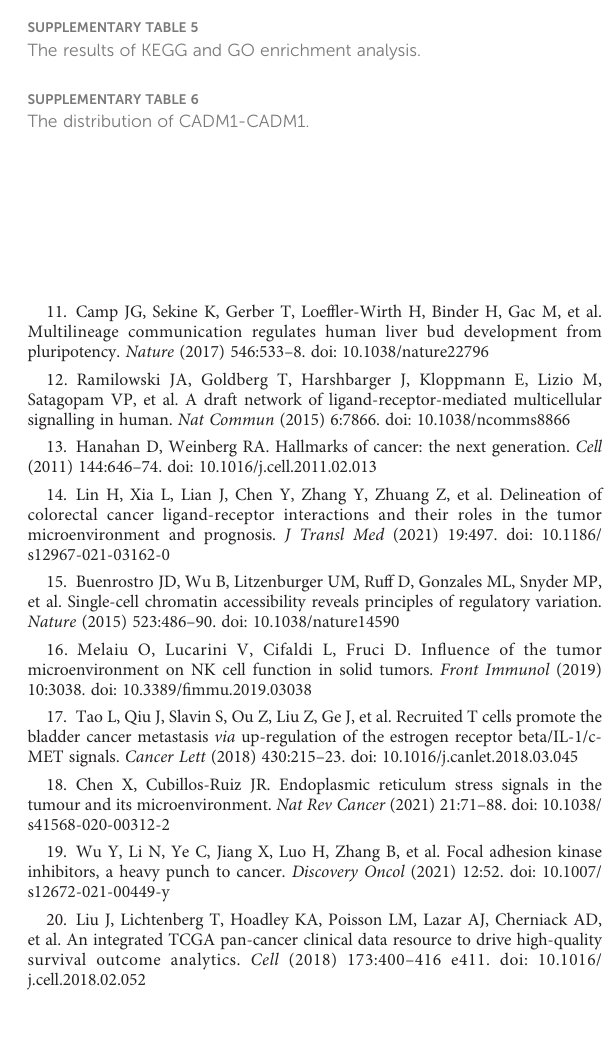
SUPPLEMENTARY FIGURE 5 PFI KM curve of CADM1-CADM1.